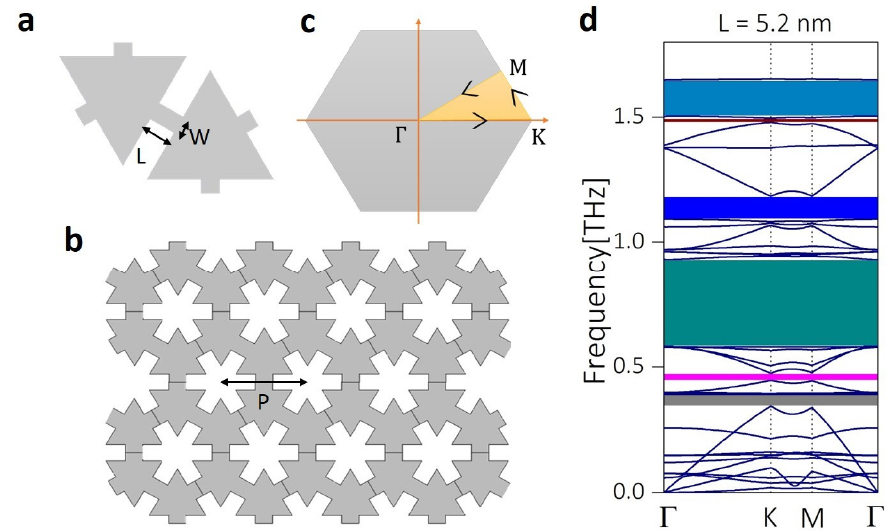
Figure 1. ( a ) Schematic representation of the unit cell of the hexagonal snowflake phononic crystal. L and W are the length and width of the neck of the snowflake structure. ( b ) Supercell of the snowflake phononic crystal formed when the unit cell shown in (a) is repeated in both the x and y directions. The periodicity, P, represents the distance between the centers of two snowflake nanopores and is fixed to be 25 nm throughout the calculation. ( c ) Schematic diagram showing the Brillouin zone of the hexagonal lattice. The shaded region Γ → K → M → Γ represents the path along which the phononic band structure calculation is performed. ( d ) The phononic band structure calculated for snowflake structure with neck length 5.2 nm showing the bandgaps in the THz regime which is desirable for heat phonon frequency controllability in thermoelectric devices.